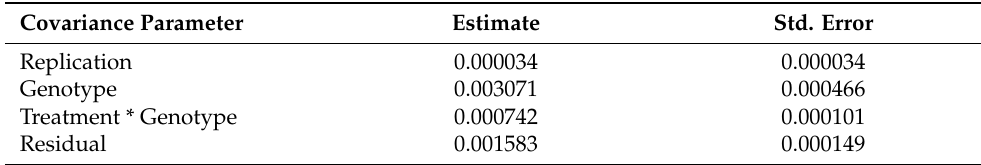
Table 2. Covariance Parameter Estimates of the random effects of